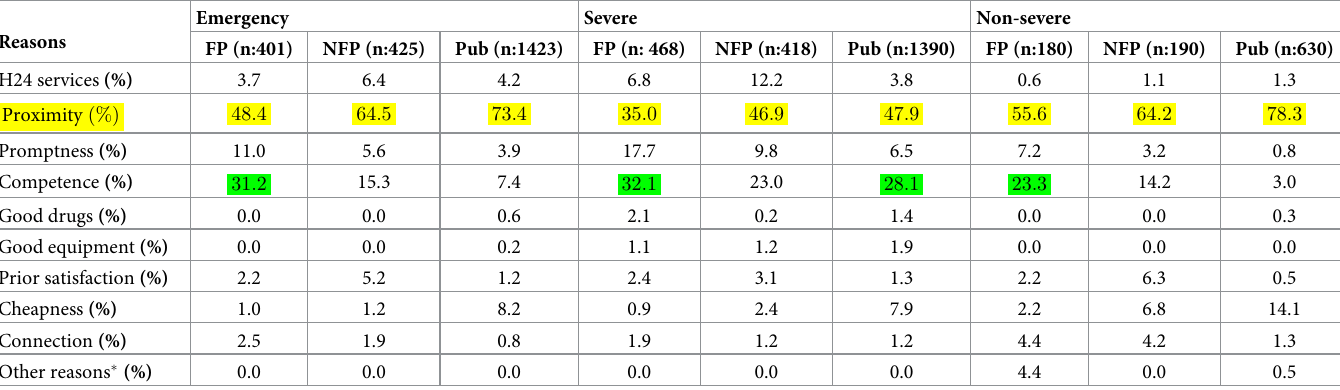
Table 6. Reasons prompting different formal providers’ (FP, NFP, Public)